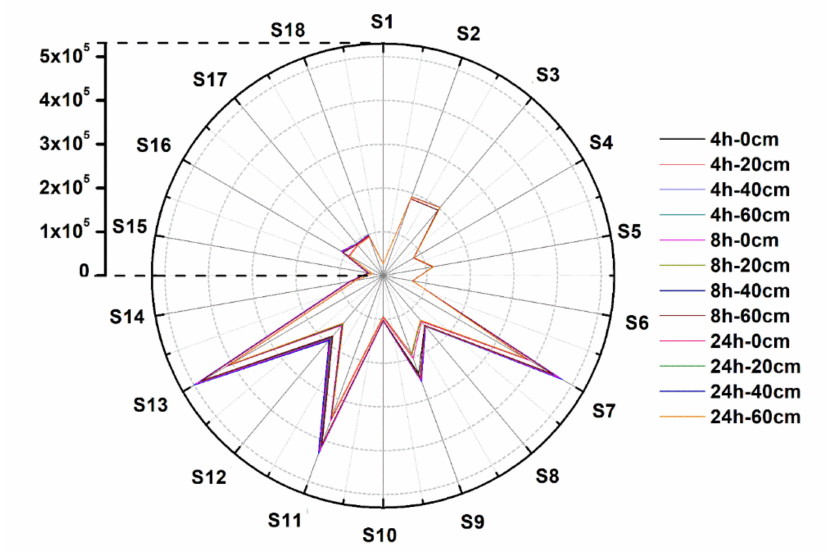
Figure 2. Polar plot of the average response data of the e-nose signal for strawberries that have suffered different extents of impact and have been stored for different times after the occurrence of the impact.